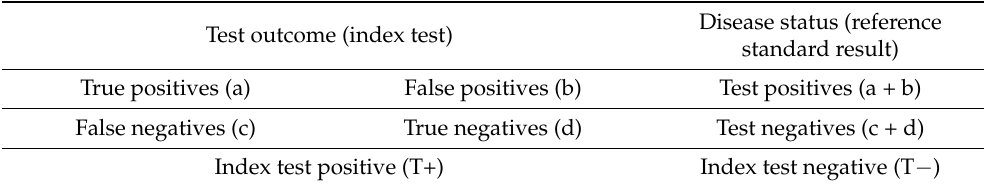
Table 2. Sensitivity and Specificity assessment for diagnostic